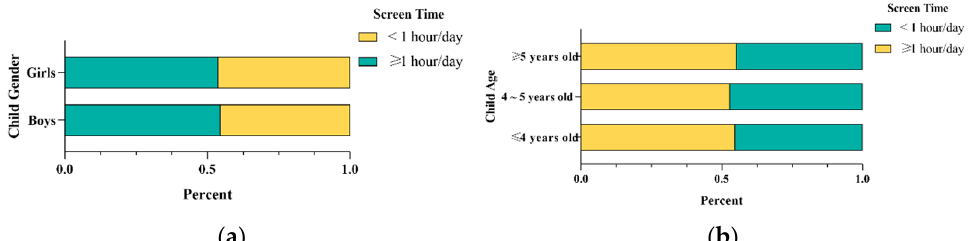
Figure 1. The age and gender distribution of screen time among preschool-age children. ( a ) Description of screen time ration by preschoolers’ gender. ( b ) Description of screen time ratio by preschoolers’ age.